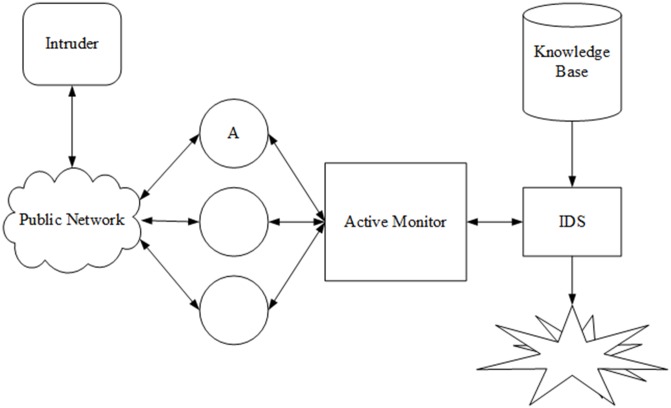
The Architecture of ID-AODV.